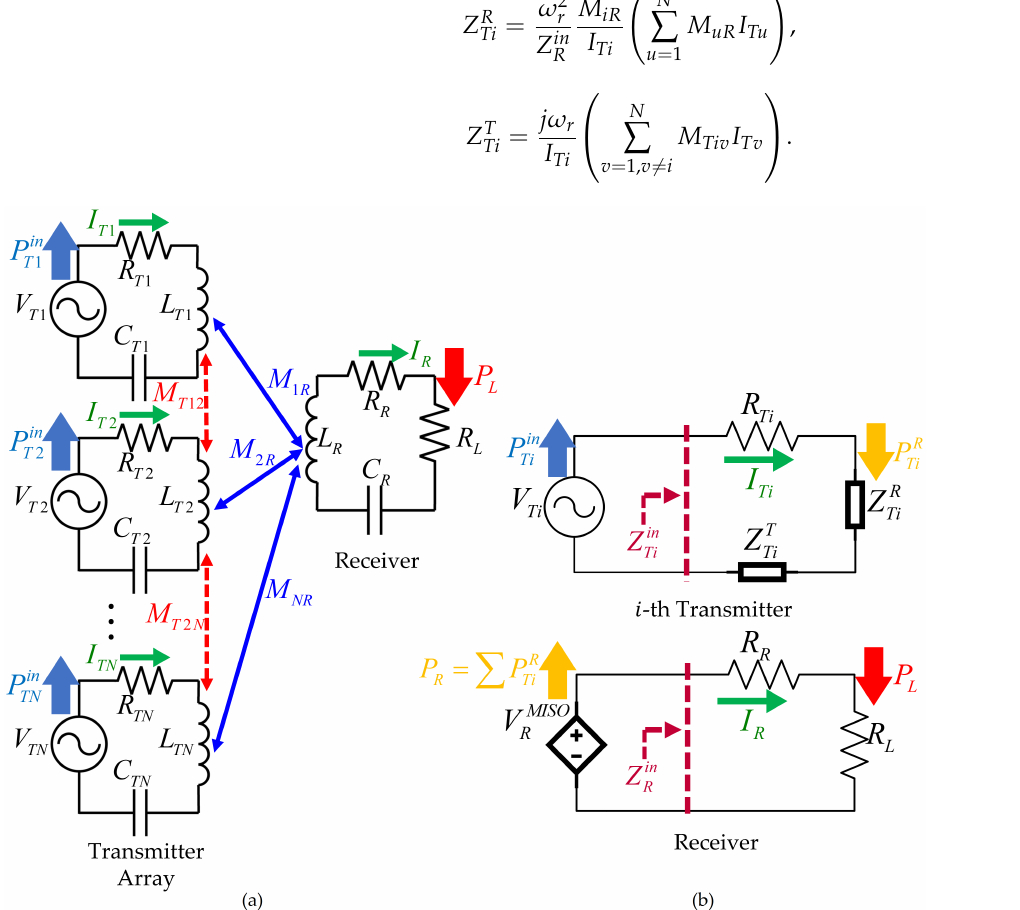
Figure 4. Circuit modeling of MISO-WPT: ( a ) simplified circuit and ( b ) equivalent circuit at magnetic